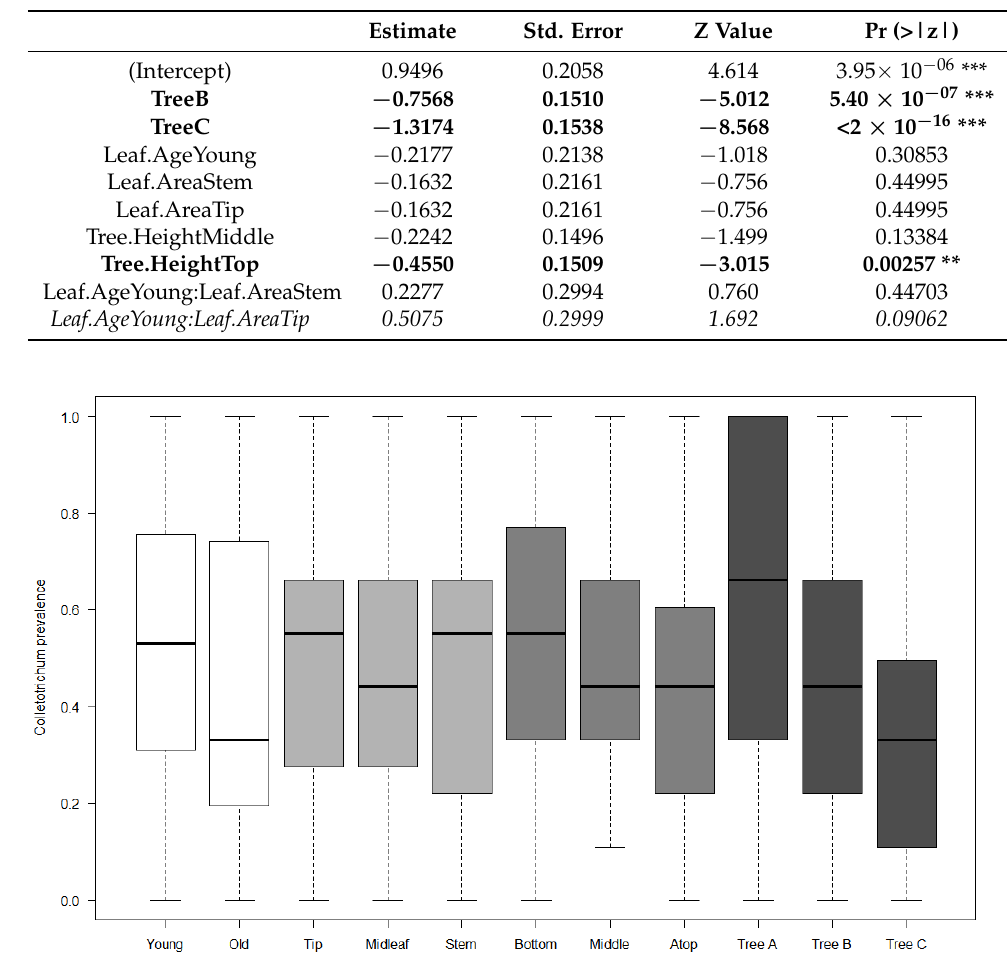
Figure 2. Rank analysis of covariate impact on prevalence in the random forest, example from fitting general prevalence of Colletotrichum on all sample trees (last column of Table 2). Meteorological co- variates are ranked by average increase in node purity in tree models from the forest, i.e., its impact on variance at the node. Covariates with a 2 in their names are reflecting weather conditions from the week preceding the prevalence estimate, while those without are weather conditions from the same week as the prevalence estimate.